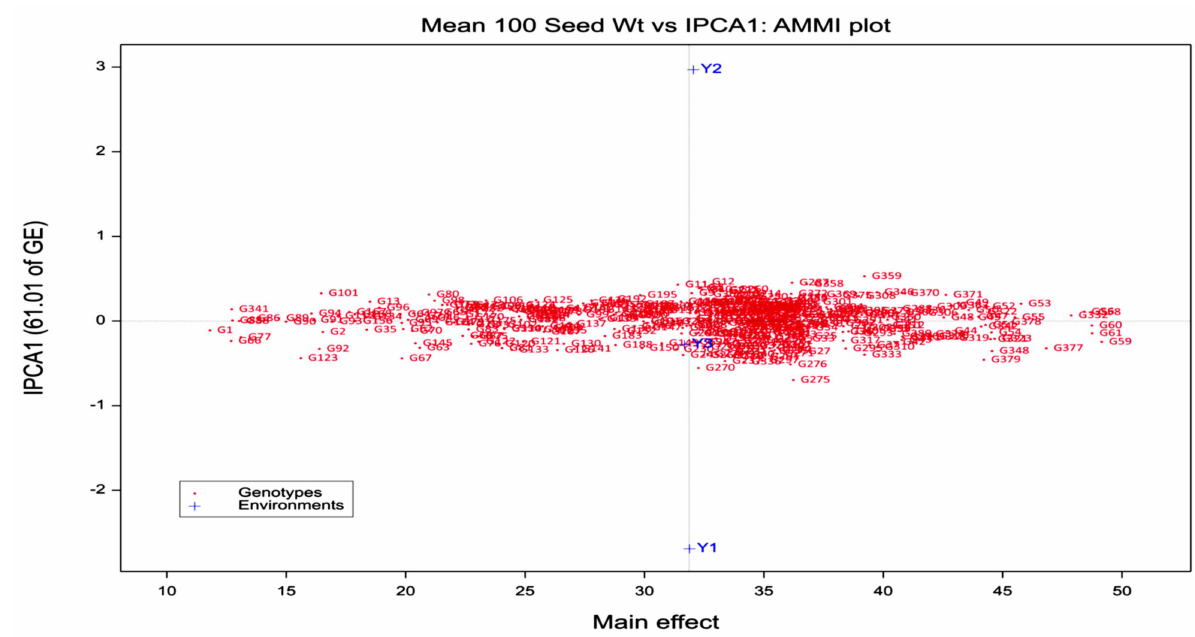
Figure 1. AMMI1 biplot for seed weight.